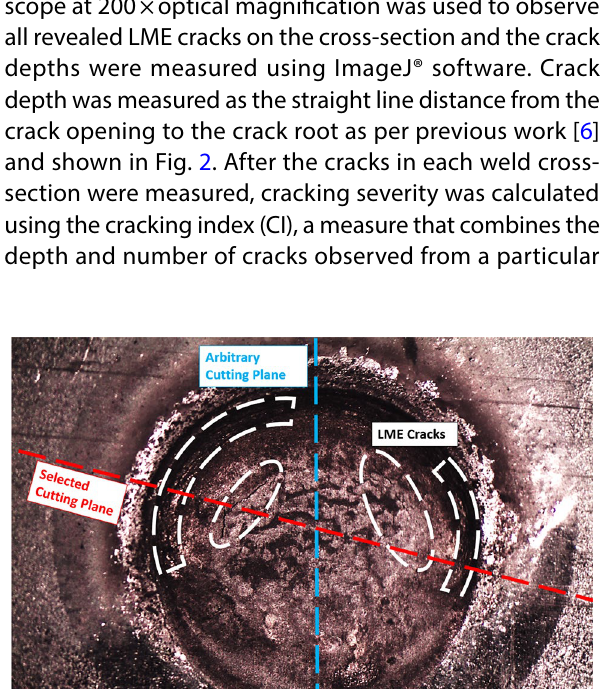
Fig. 2 Examples of cross-sections of cracked welds using the a selected and b arbitrary cutting plane methods, with increased magnification images of the weld shoulder from cross-sections c